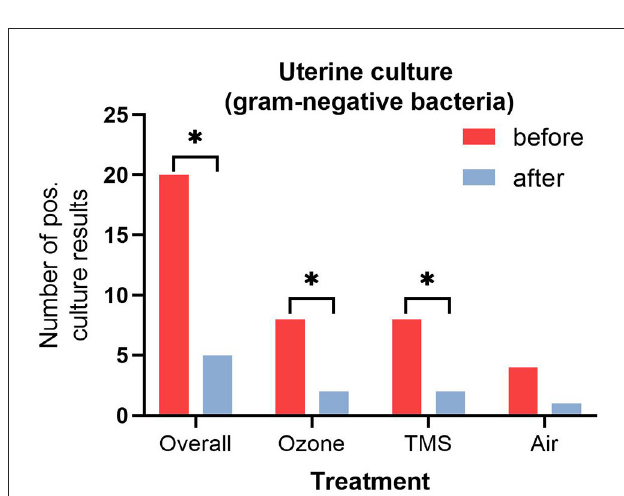
FIGURE3 Number of positive uterine culture results (gram-negative bacteria) before and after treatment. Asteriks ( * ) indicate significant difference between pre- and post-treatment results as determined by non-parametric U-test (Wilcoxon; p < 0.05).